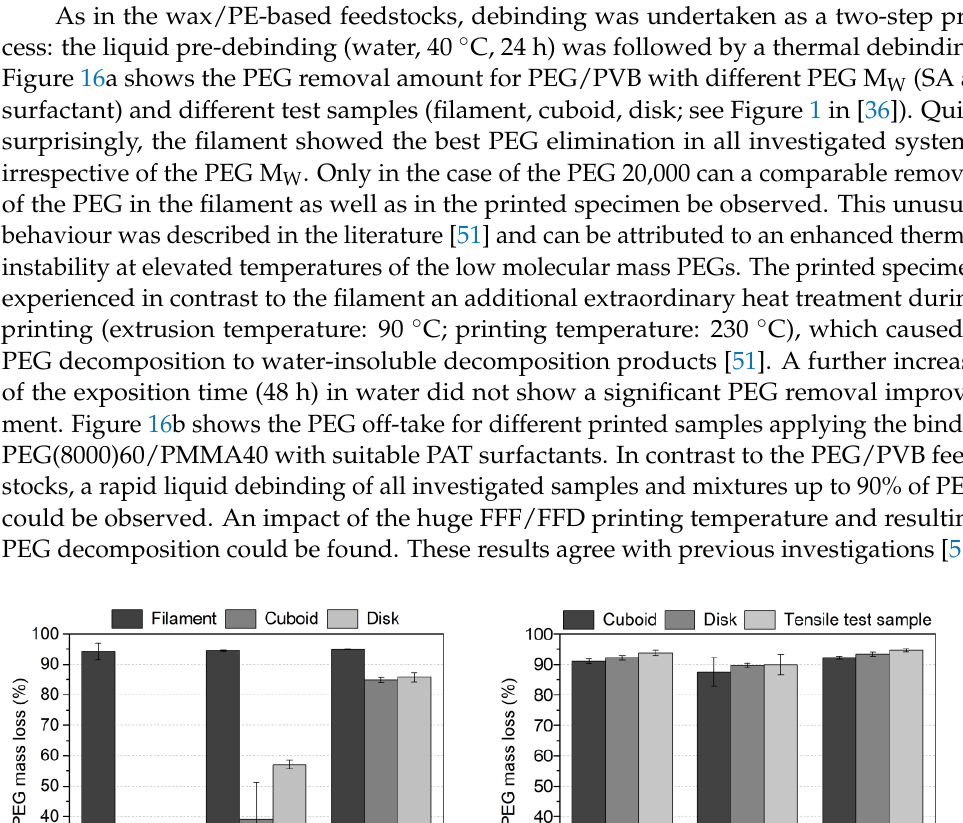
structure with long cantilever and holes [18]; ( c ) planetary gear train (FFF); ( d ) screws (FFD).